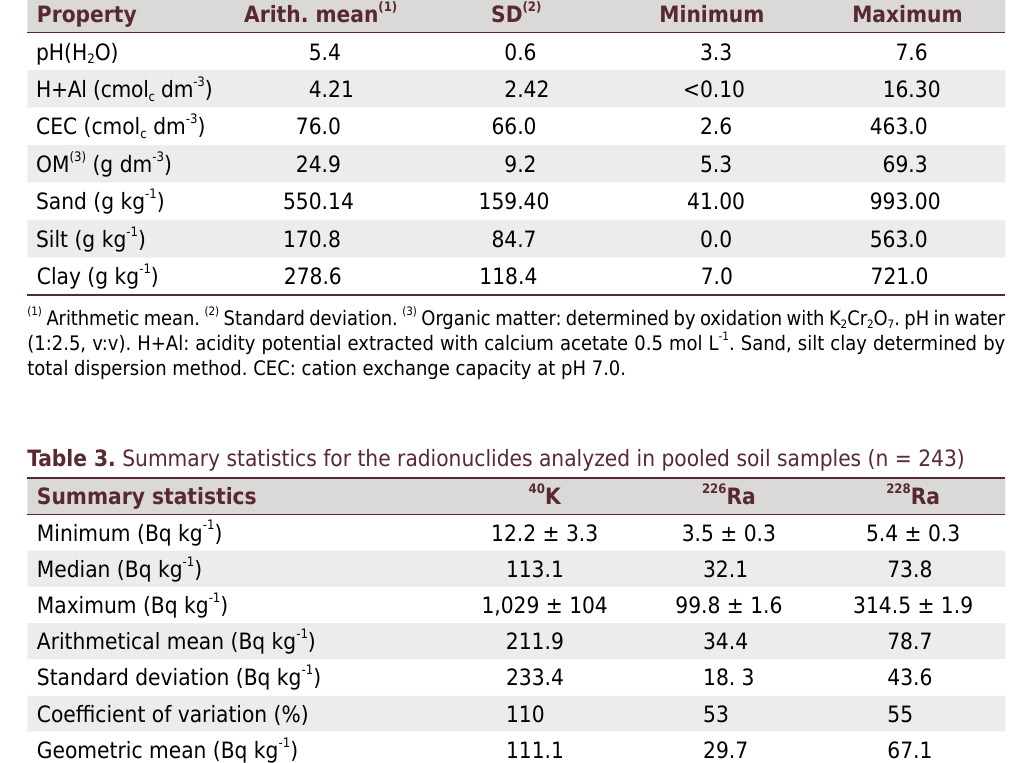
Table 2. Summary of statistical analysis of the physical and chemical properties of soil samples (n = 243)